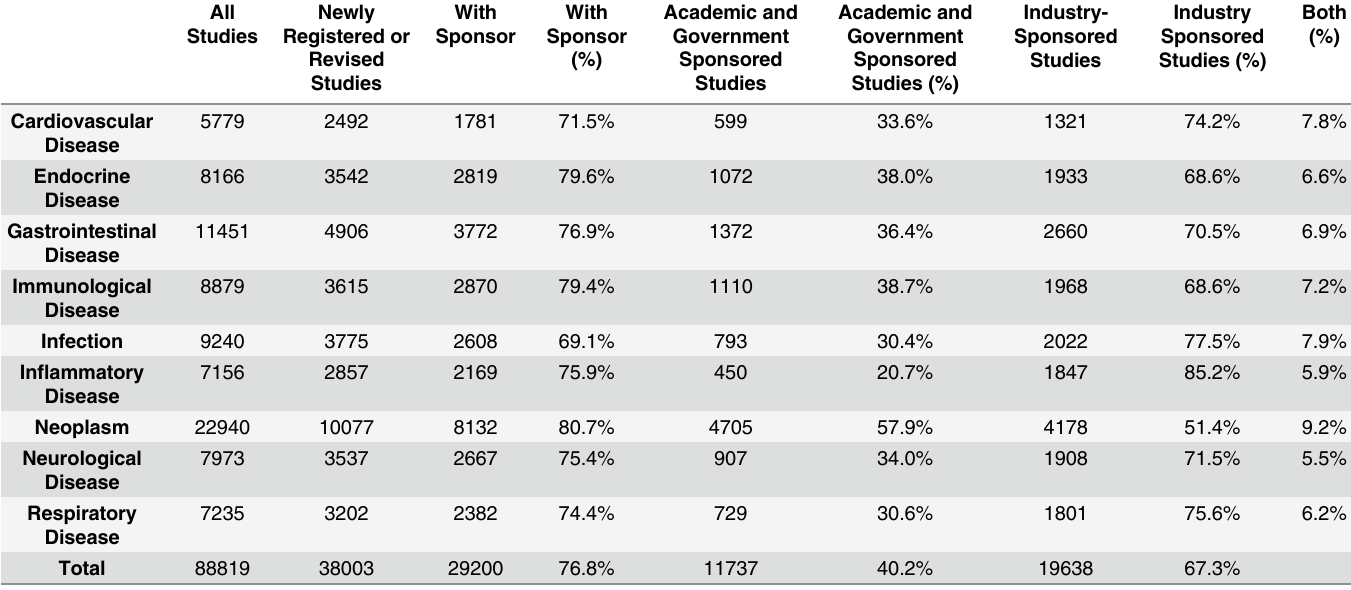
Table 1. Characteristics of Studies Registered in ClinicalTrials.gov During